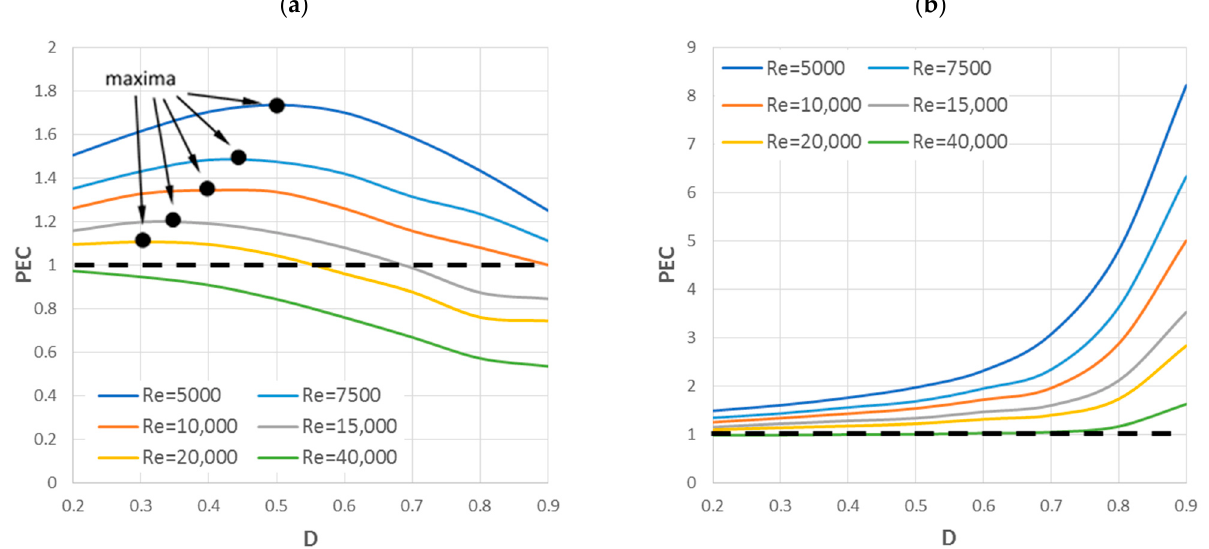
Figure 12. PEC( D ) characteristics calculated by two methods: ( a ) for the average temperature of the entire pipe section; ( b ) for the average temperature of the annular section.